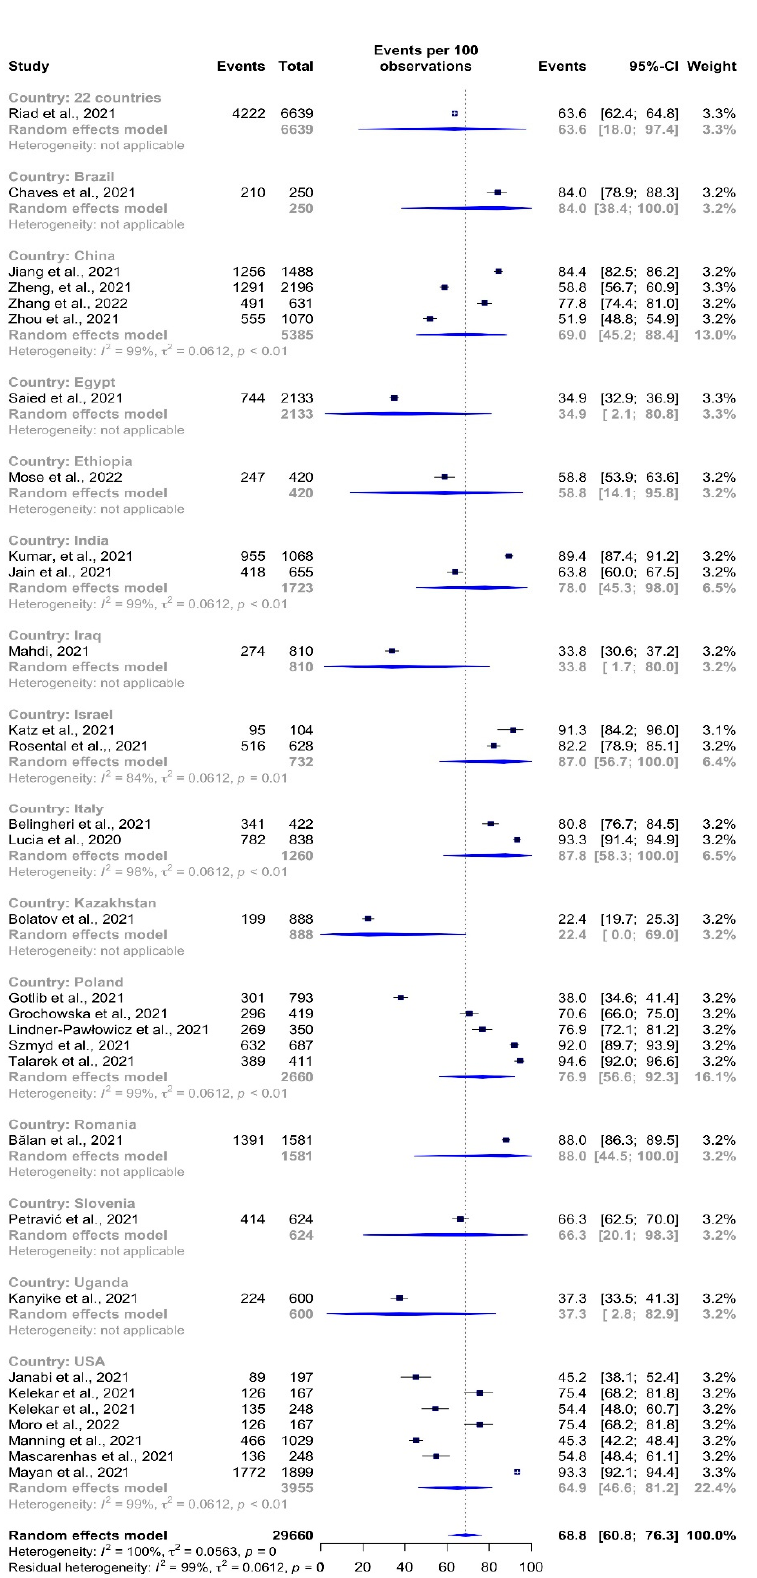
Figure 5. COVID-19 vaccine acceptance rates among healthcare students by country. Country sub-group analyses are presented in Figure 6. Iraq showed the highest rates of vaccine hesitancy (66.2%, 95% CI: 35.5–90.8%), followed by Egypt (45.5%, 95% CI: